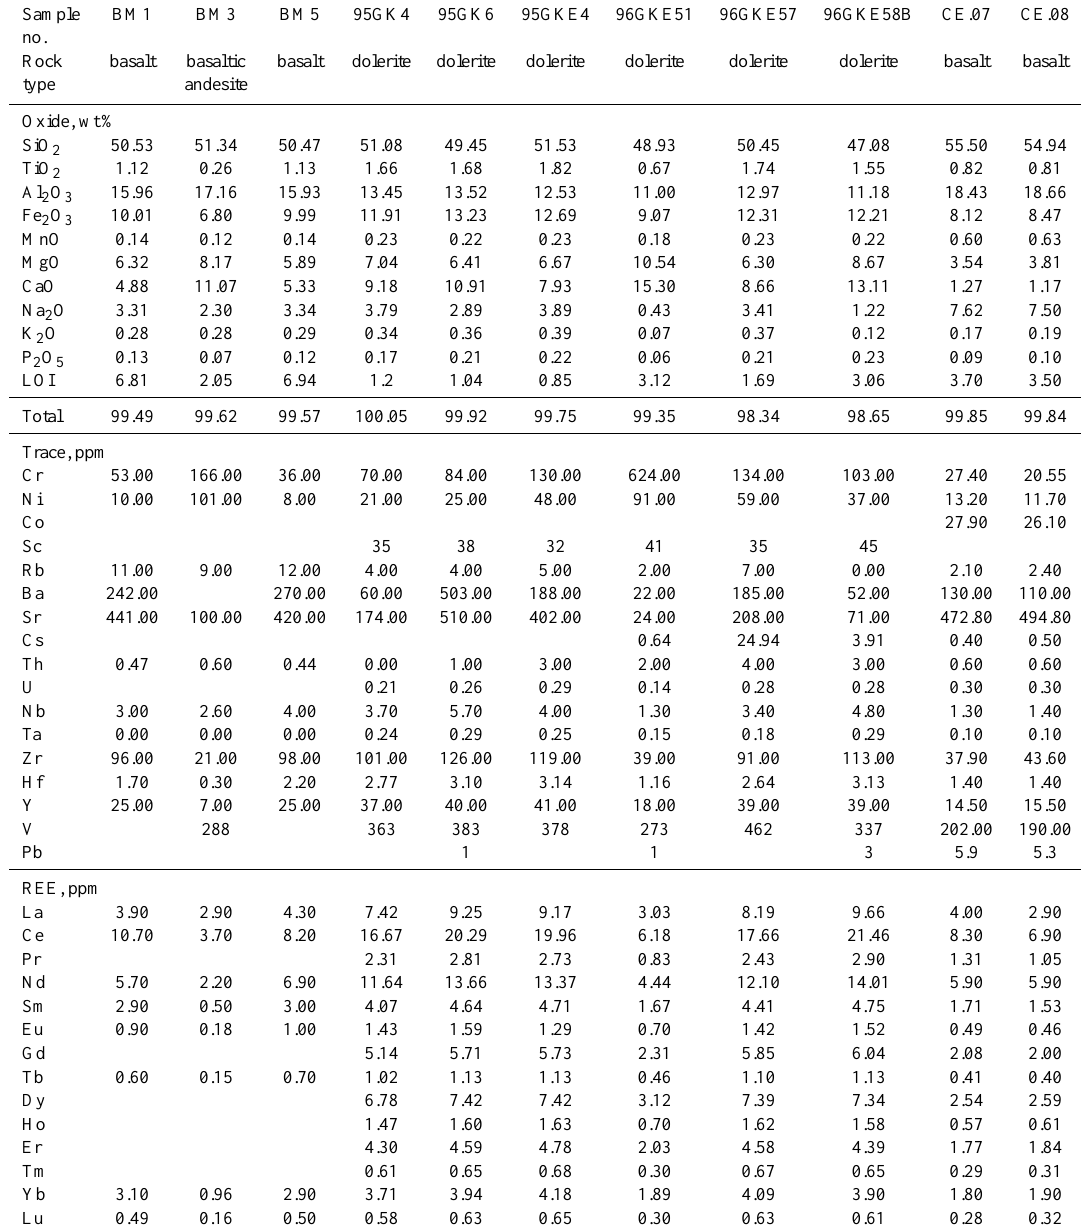
Table 5. Major, trace element and REE data for a select group of volcanic and dike rocks from the Neotethyan ophiolitic units in the Ankara Mélange (first nine samples from Tankut et al.,